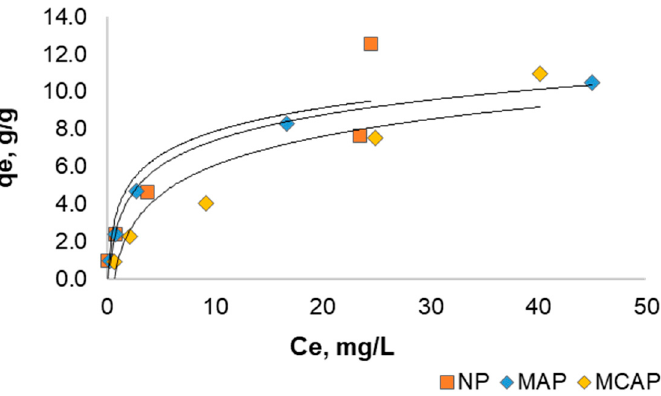
Figure 8. Equilibrium adsorption isotherms of Cu 2+ on natural peat (NP), mechanically activated peat (MAP), mechanochemically activated peat (MCAP).